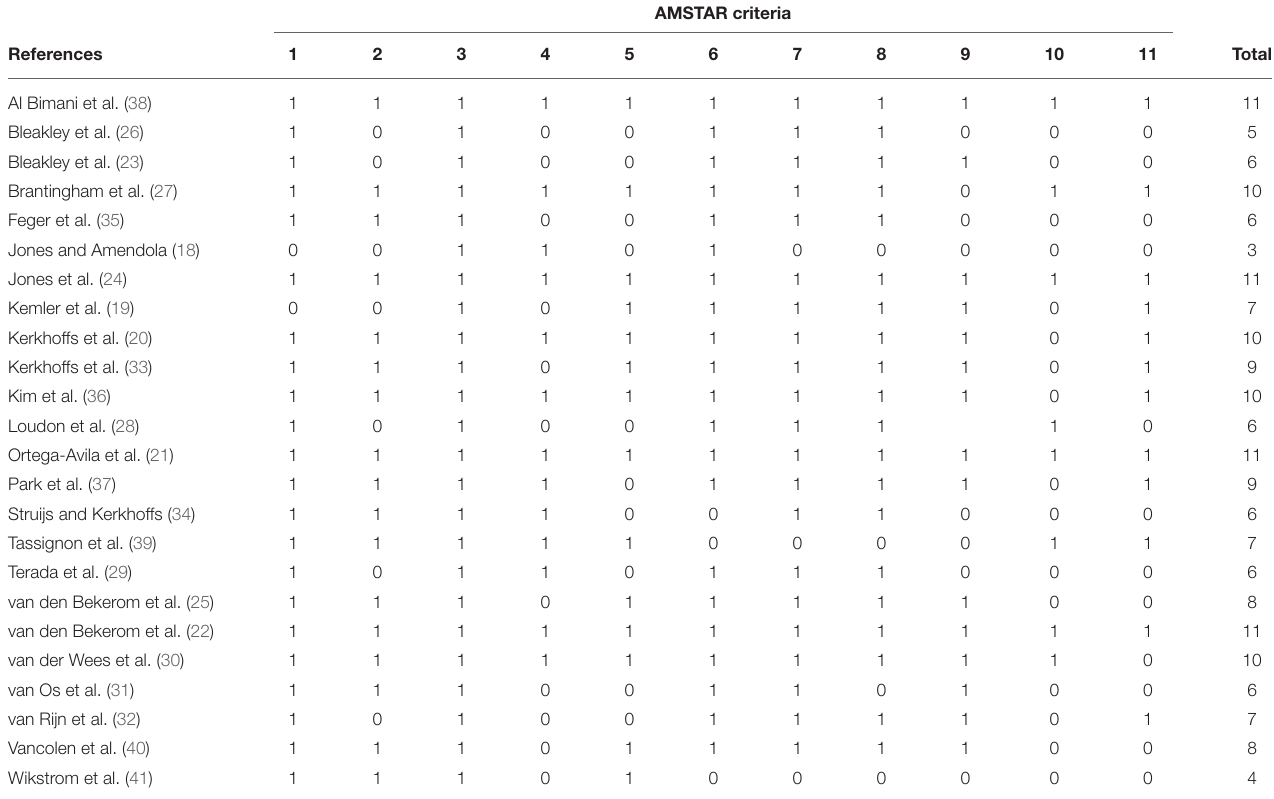
TABLE 2 | Quality assessment of the included studies according to the AMSTAR